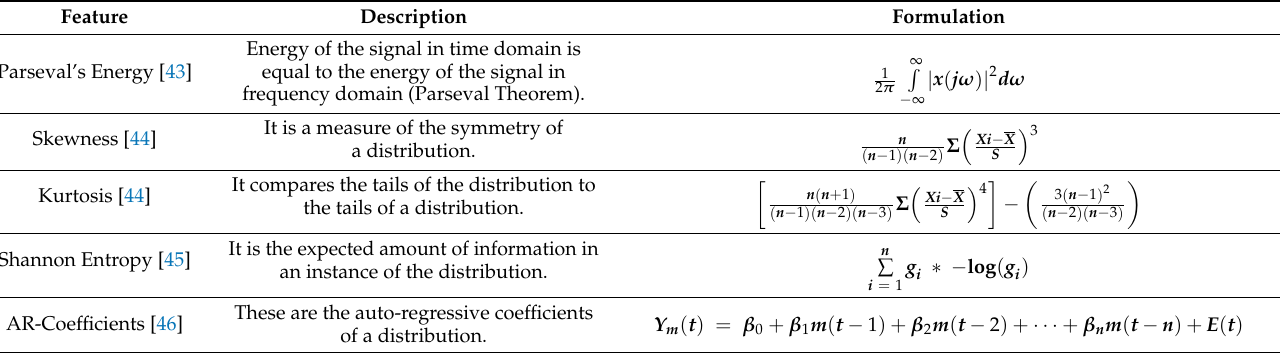
Table 1. Features extracted for human locomotion activity signal.